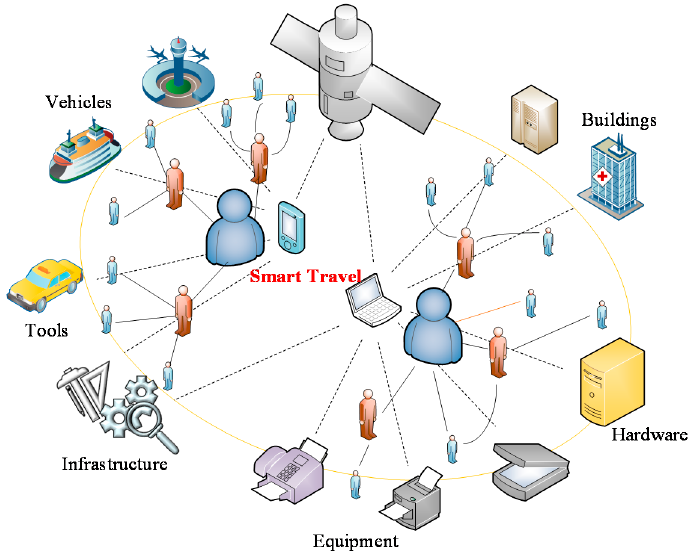
Figure 3. The application of smart tourism.